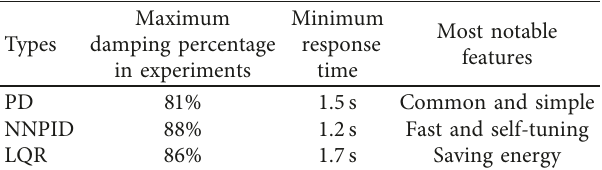
Table 5: Comparison of three